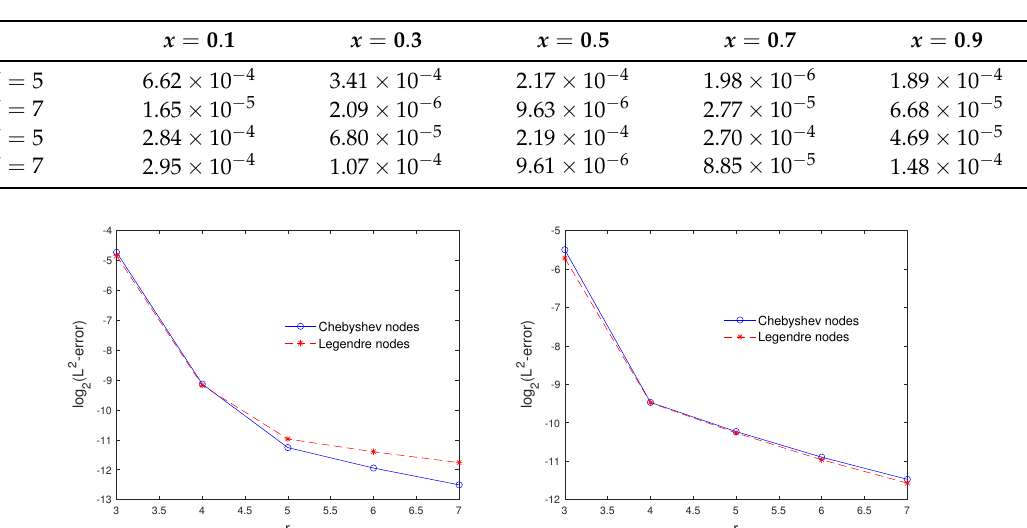
Table 2. The L ∞ –error taking µ = 5/6 for Example 1.